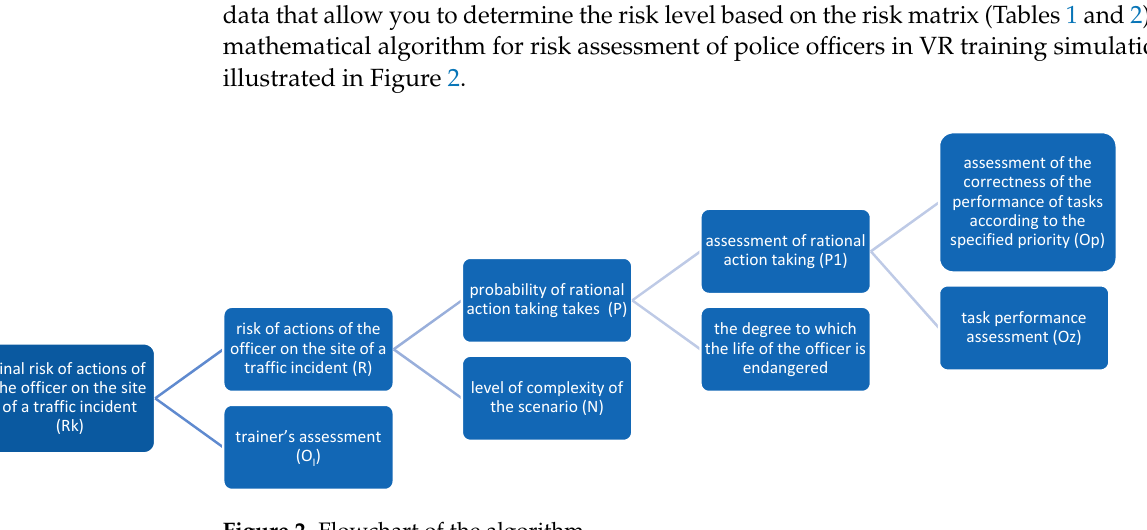
Figure 2. Flowchart of the algorithm.